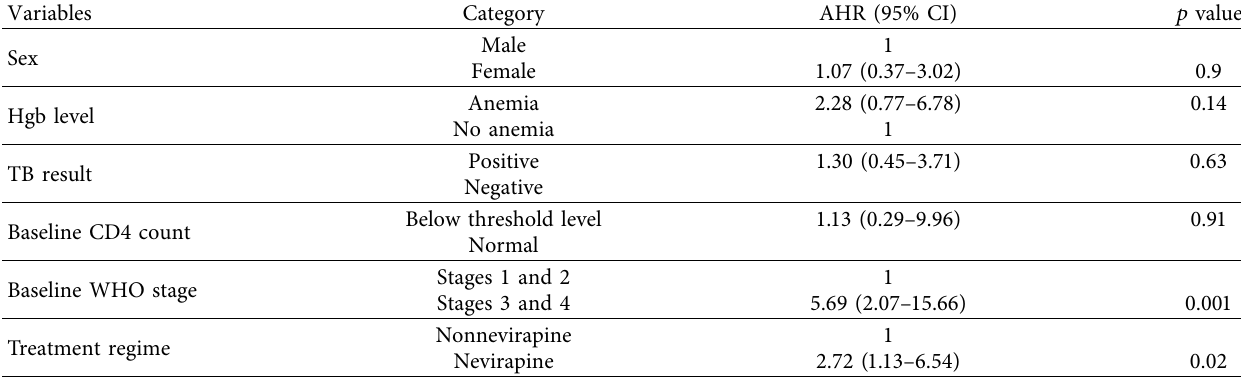
Table 5: The overall predictors of time to first-line treatment failure among children started ART.